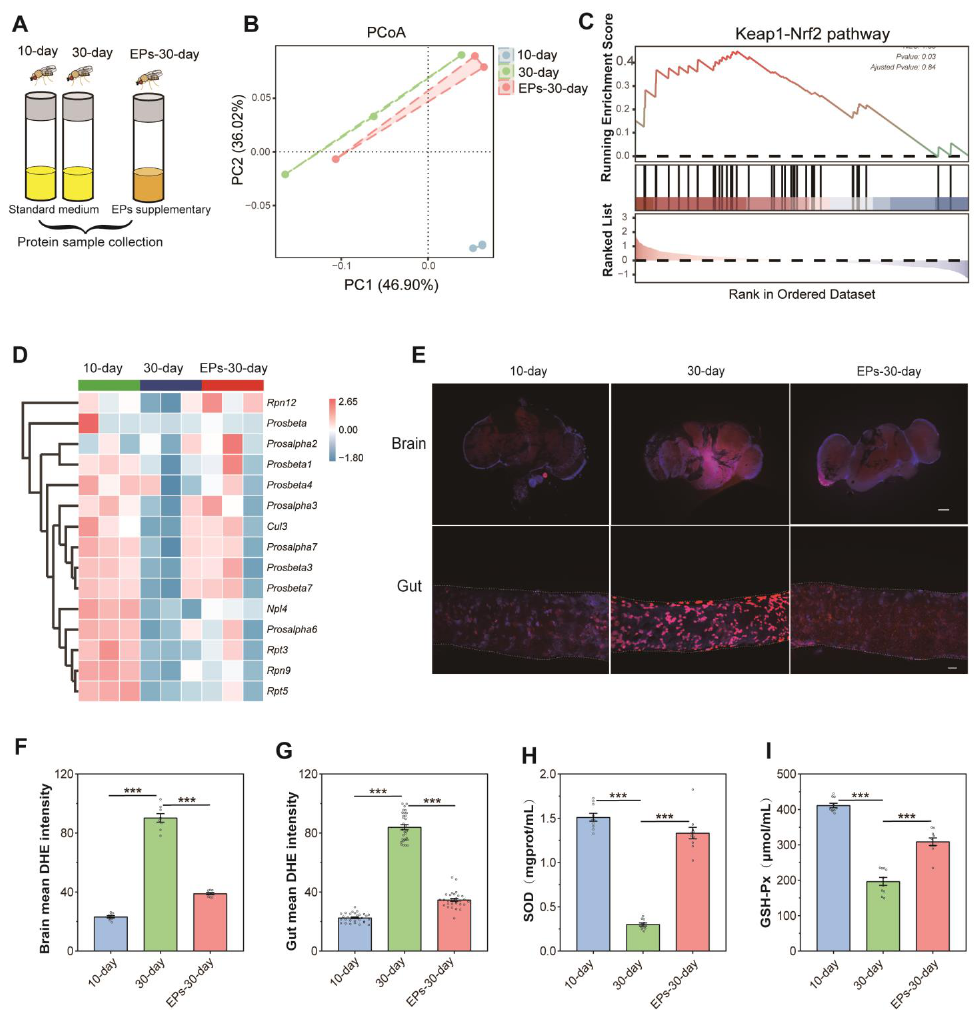
Figure 4. EPs inhibited oxidative stress in aged Drosophila. ( A ) Schematic diagram of the proteomics procedure (10-day- and 30-day-old flies in the control group and 30-day-old flies in the EP groups, 25 males and 25 females per sample, n = 3). ( B ) PCoA of the proteomics of 10-day- and 30-day-old flies in the control group and 30-day-old flies in the EP groups. ( C ) GSEA plot depicting the enrichment proteins involved in Keap1–Nrf2 signaling (NES = 1.33, p = 0.03). Red: aged (positively correlated), Blue (negatively correlated). ( D ) Heatmap of the enrichment proteins involved in Keap1–Nrf2 signaling. ( E ) DHE staining in the brains (upper) and guts (below) of 10-day- and 30-day-old flies in the control group and 30-day-old flies in the EP groups (bar = 100 µ m). ( F ) DHE intensity of